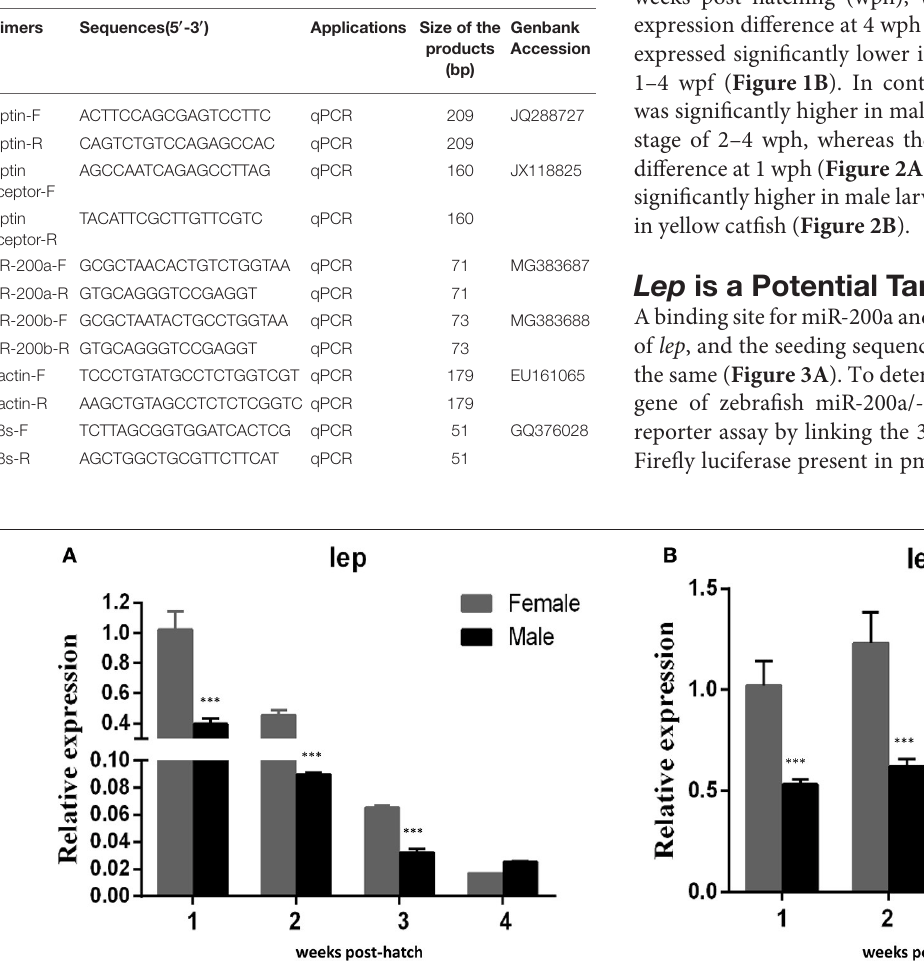
Frontiers in Physiology |